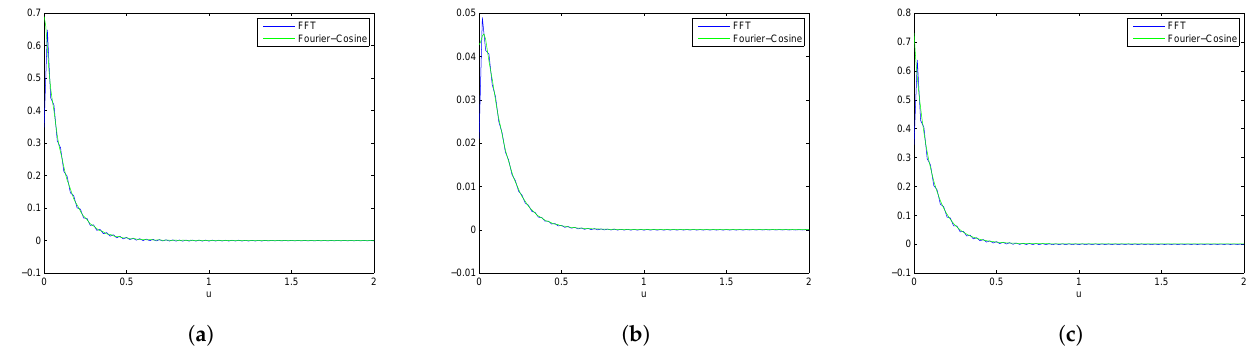
Figure 1. For the Lévy-Gamma risk model, we compare Fourier–Cosine method with FFT method. ( a ) Ruin probability; ( b ) Expected claim size causing ruin; ( c ) Laplace transform of ruin